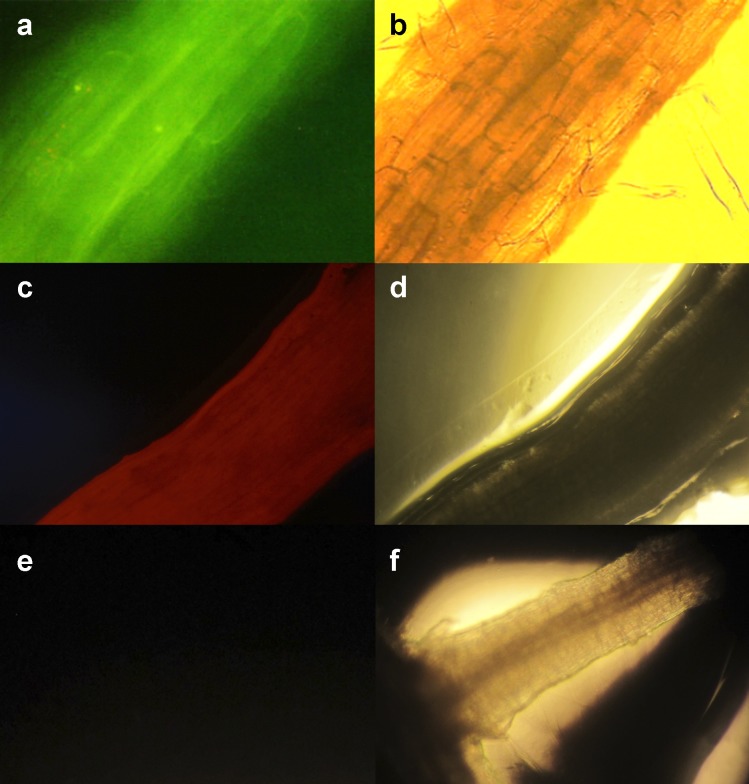
Confirmation of genetic transformation.Genetic transformation was corroborated by epifluorescence of induced
hairy roots of Hyptis suaveolens with the strain
K599+pGus-GFP+ (a, and b) and the strain
ATCC15834+pTDT (c, and d). Observed in
darkness and illuminated with blue (a), green
(c), and white lights (b, d,
and f). When nontransformed roots were illuminated with
blue or green light, epifluorescence was not observed (e).
All microphotographs are 20X.